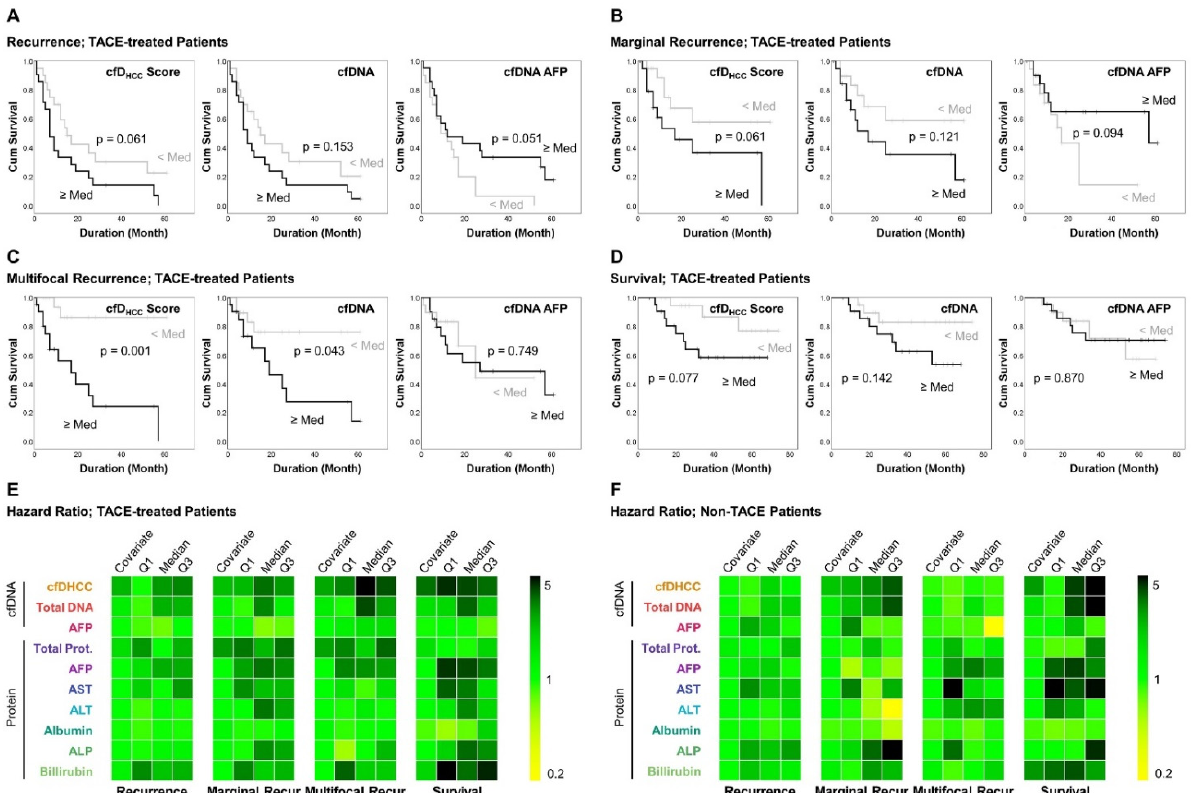
Figure 4. The clinical performance of cfDNA for predicting the survival outcomes: Kaplan–Meier survival analysis for ( A ) recurrence, ( B ) marginal recurrence, ( C ) multifocal recurrence, and ( D ) overall survival of TACE ‐ treated patients. Univariate Cox regression analysis of the serum and plasma biomarkers for ( E ) TACE ‐ treated and ( F ) non ‐ treated patients.